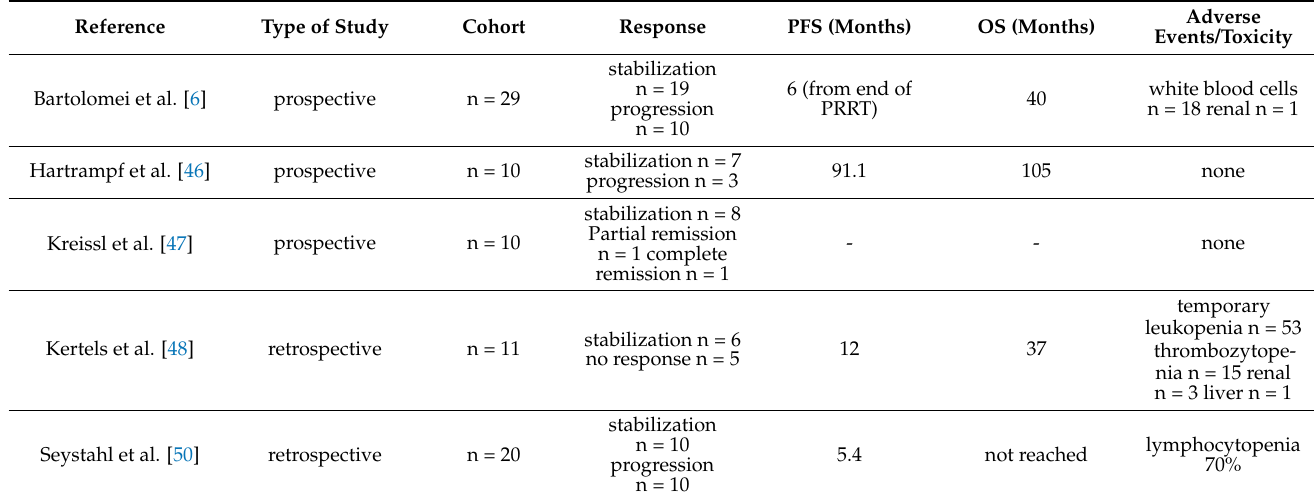
Table 1. Studies that have investigated the effect of PRRT on